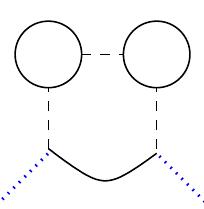
Figure 2 . An example of a graph with one tetravalent and two trivalent